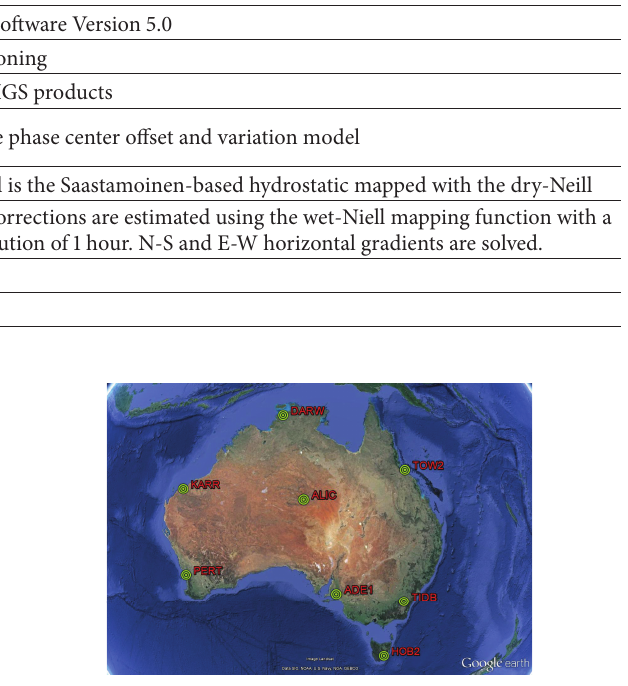
Figure 1: A Google Earth map showing locations of the eight Australian GNSS sites used in the study. ADE1: Adelaide, ALIC: Alice Springs, DARW: Darwin, HOB2: Hobart; KARR: Karratha, PERT: Perth, TIDB: Tidbinbilla, and TOW2: